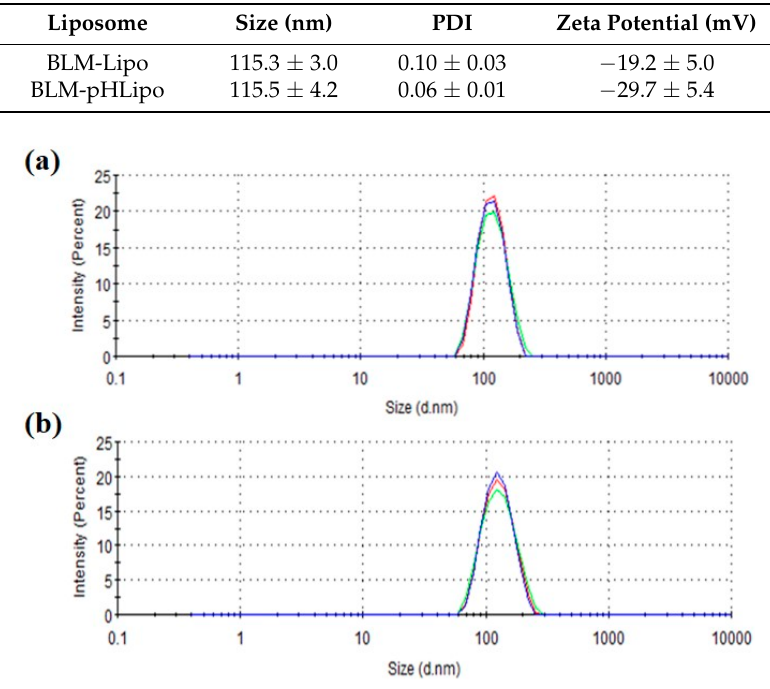
Figure 2. Intensity-weighted size distribution of BLM-loaded PEG liposomes without (( a ) BLM-Lipo) and with CHexPG-PE (( b ) BLM-pHLipo). Red, blue and green lines indicate the results for three different measurements.